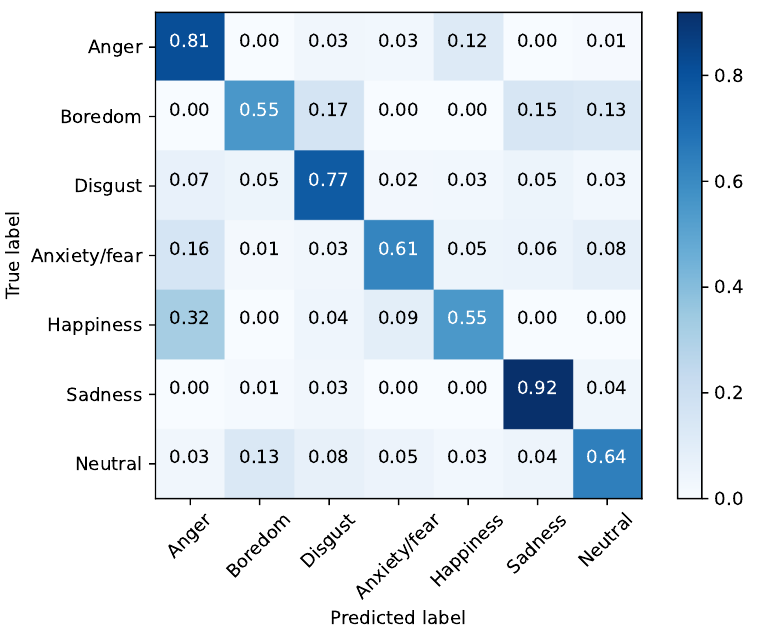
Figure 7. Normalized confusion matrix of the original database as test set and the proposed model “All scenarios ∆ SNR = 3 dB” as training set on the EMO-db